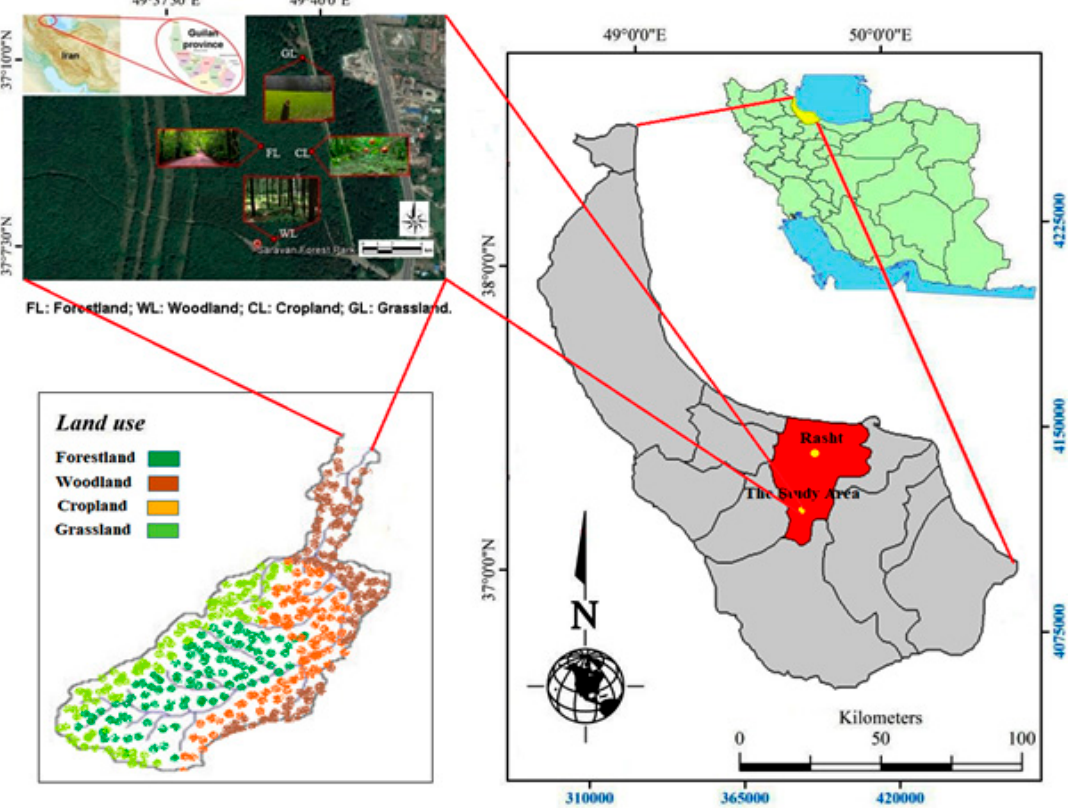
Figure 1. Geographical location and aerial map (source: Google ® Map ® ) with soil sampling points of the study area.